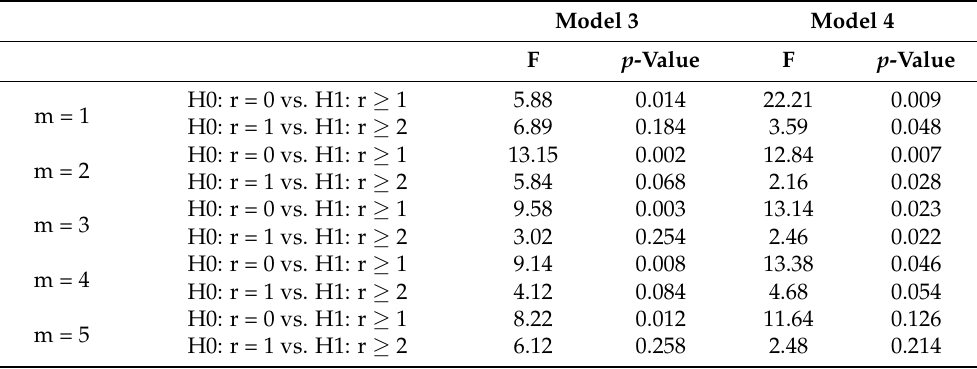
Table 8. Residual nonlinear test.